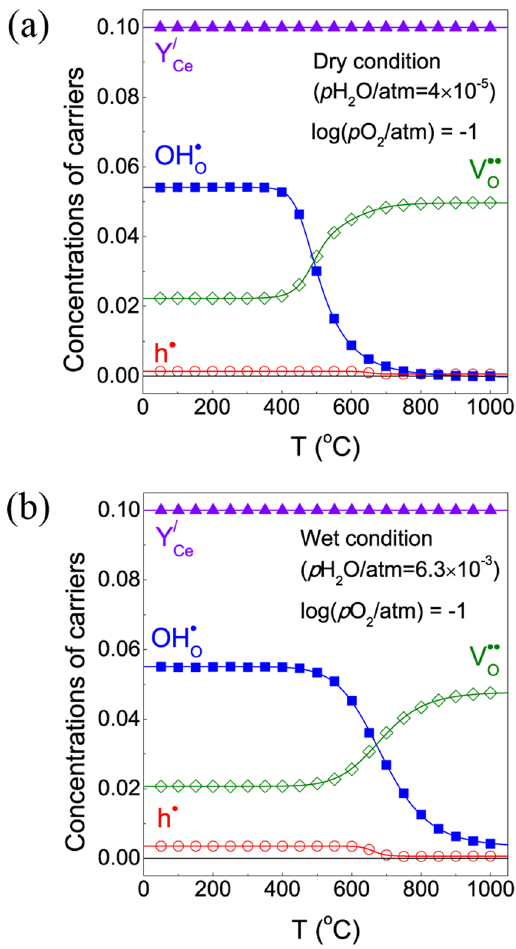
Figure 2. Concentrations of charge carriers under ( a ) dry condition ( p H 2 O = 4.0 × 10 − 5 atm) and ( b ) wet condition ( p H 2 O = 0.0063